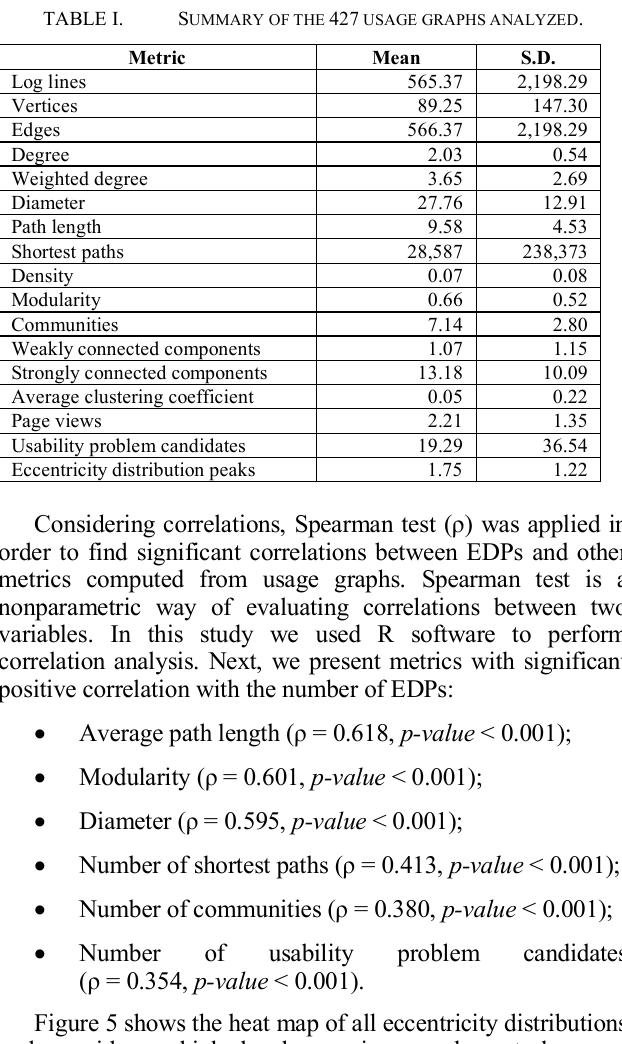
Fig. 5. Eccentricity distribution heat map for all the studied sessions; eccentricity and frequency are